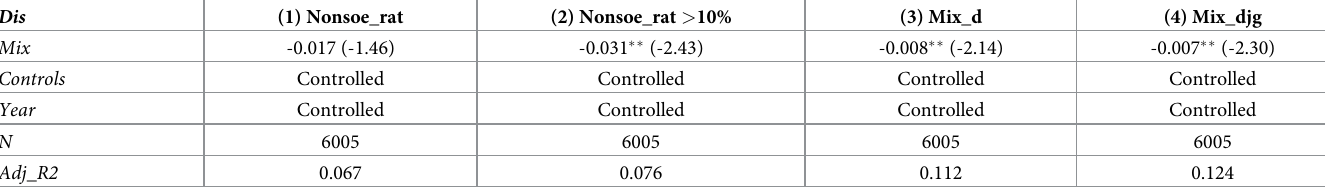
Table 4. The non-state-owned shareholder ‘s governance and the degree of deviation of capital structure.